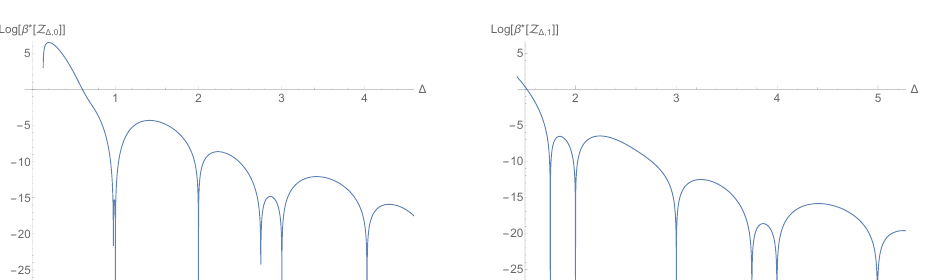
CFT. We set N max = 55 and j max = 40. 5 . 5